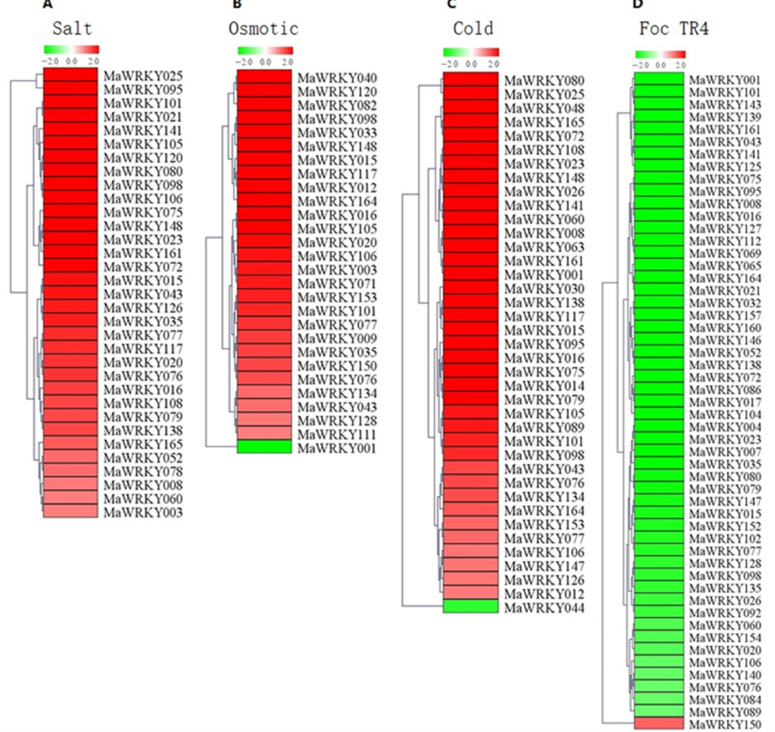
Figure 5. Expression patterns of MaWRKYs in response to abiotic and biotic stress. ( A ) salt; ( B ) osmotic; ( C ) cold; ( D ) Foc TR4.